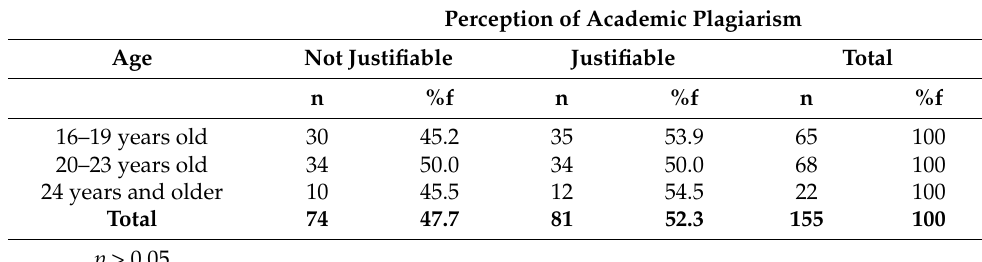
Table 5. Level of perception of academic plagiarism in students at the industrial engineering school of a public university in Lima according to